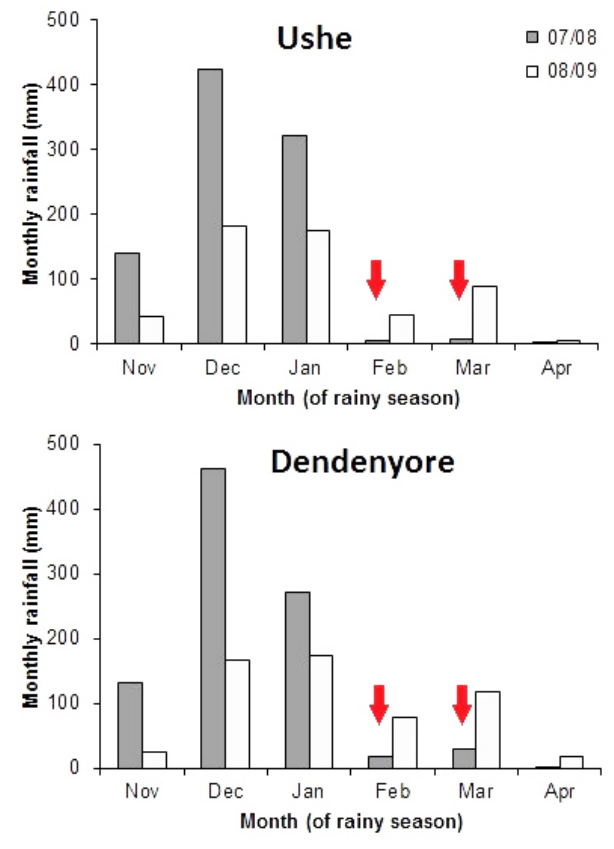
Fig. 4 . Monthly rainfall in Ushe and Dendenyore during the 2007-2008 and the 2008-2009 growing